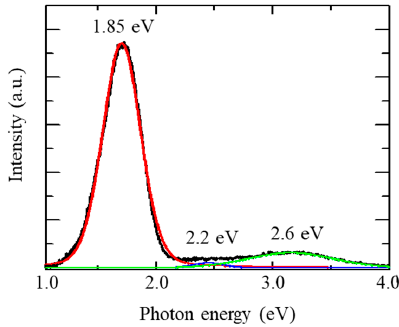
Figure 3. The obtained typical CL spectra from a thermally-oxidized SiO 2 thin film. A typical CL spectrum from SiO 2 (black line) and its decomposition into different contributions (red, green, and blue lines) by fitting Gaussian and Lorenz functions.